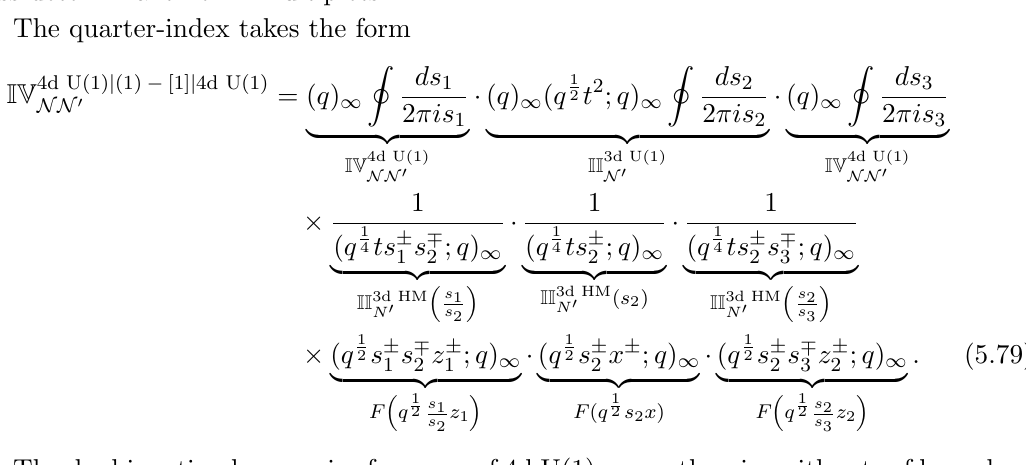
3d ( M ) [1] 4d U( N ) with | − | ) and a boundary of 3d U(1) , N N (cid:31)